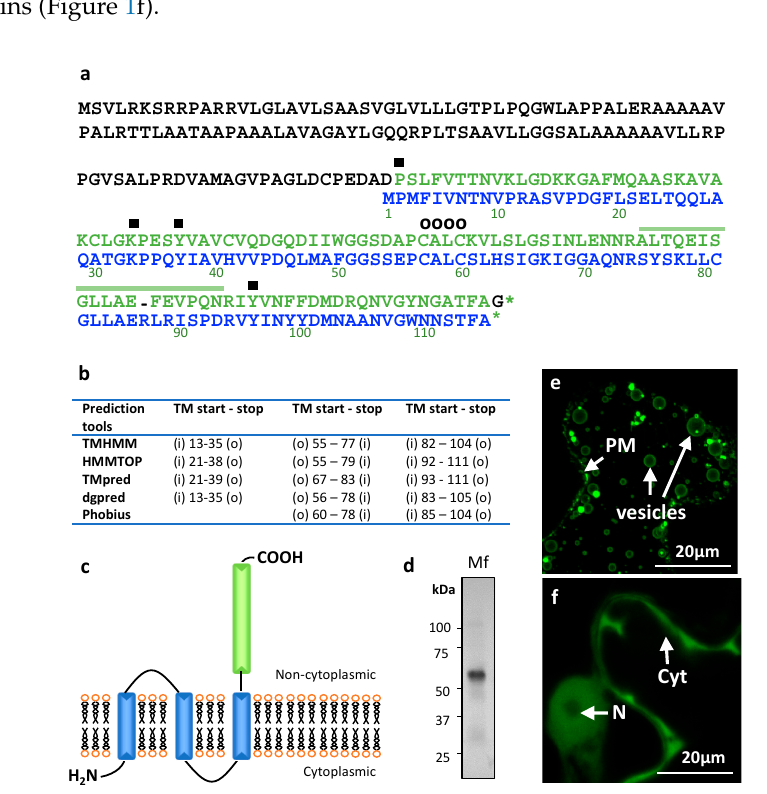
Figure 1. Lingulodinium polyedra expresses transmembrane Migration Inhibitory Factors (MIF). ( a ) Alignment of the L. polyedra MIF (LpMIF) sequence with human MIF (dark green). Amino acid numbers of the human MIF are given below the sequence. Hyphens (-) indicate a gap in the respective sequence. Amino acids shown to determine the tautomerase activity ( ■ ) and oxidoreductase activity (CXXC motif; O) in human MIF are shown by symbols above the sequence. The peptide identified by mass spectrometry is indicated by a line above the LpMIF sequence. ( b ) Location (LpMIF amino-acid number) and orientation of the transmembrane helices predicted by five prediction tools, where « i » refers to inside (cytoplasmic) and « o » to « outside » (non-cytoplasmic). ( c ) Schematic representation of the predicted LpMIF topology. The transmembrane domains are represented in blue and the MIF domain in green. The membrane is represented as a lipidic bilayer. ( d ) Western blot analysis of the membrane fraction (Mf) of L. polyedra proteins. The membrane extract (10 μ g of total proteins) reveals a major protein with an apparent molecular mass of about 60 kDa. The presence of LpMIF in the most prominent band of the membrane fraction was confirmed by mass spectrometry (see 1a). ( e , f ) Subcellular localization of LpMIF fused to GFP in the N-terminal region, with ( e ) or without ( f ) the transmembrane domains in Nicotiana benthamiana . Leaves were inoculated with A. tumefaciens harboring the LpMIF-GFP constructs, 2 days prior to observations. Complete LpMIF proteins localize to the membranes of vesicles and the plasma membrane (PM) ( e ), while LpMIF without the transmembrane domains (in f ) shows a nucleo-cytoplasmic expression in N. benthamiana cells, which is typical for small, soluble proteins. (N) nuclei, (Cyt)